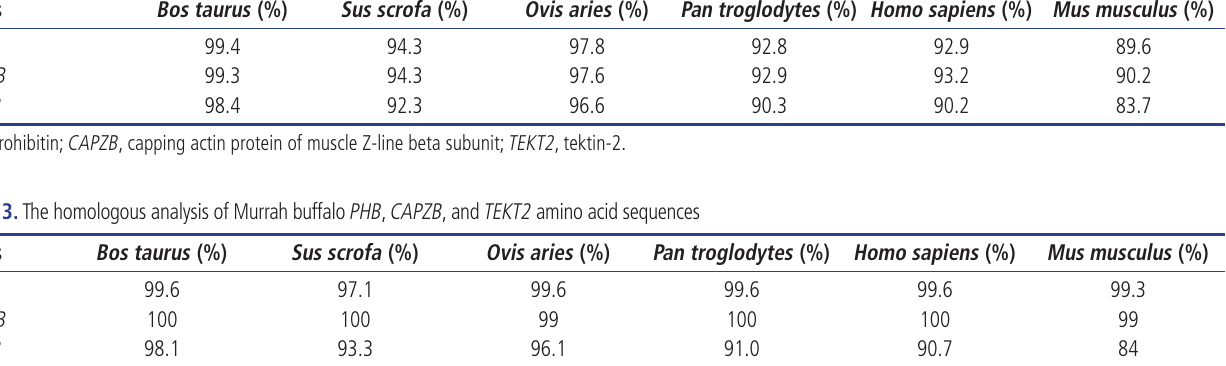
Table 2. The homologous analysis of Murrah buffalo PHB, CAPZB, and TEKT2 DNA sequences Items